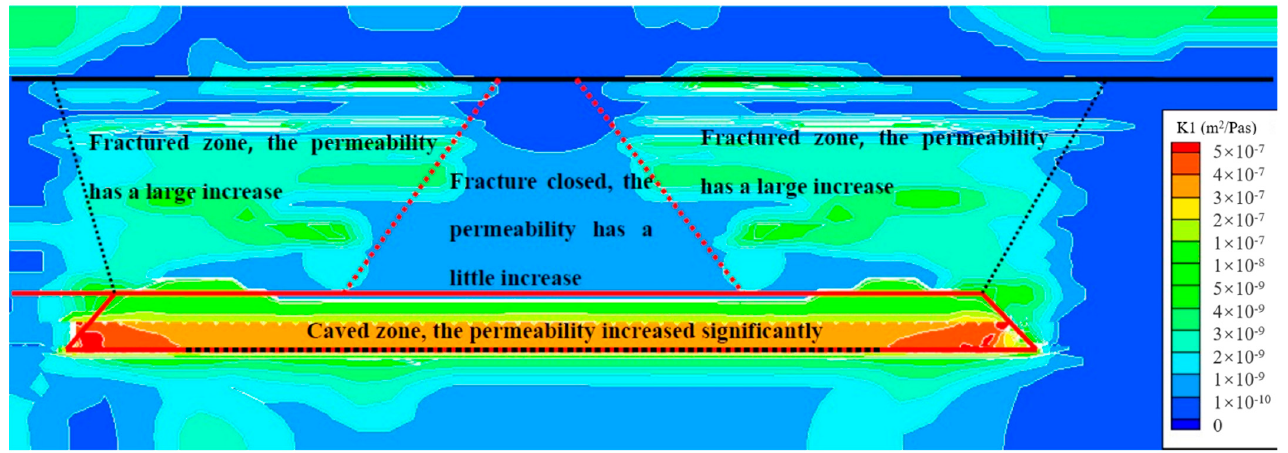
Figure 6. The contour plotting of permeability distribution on longitudinal cut plane of model.